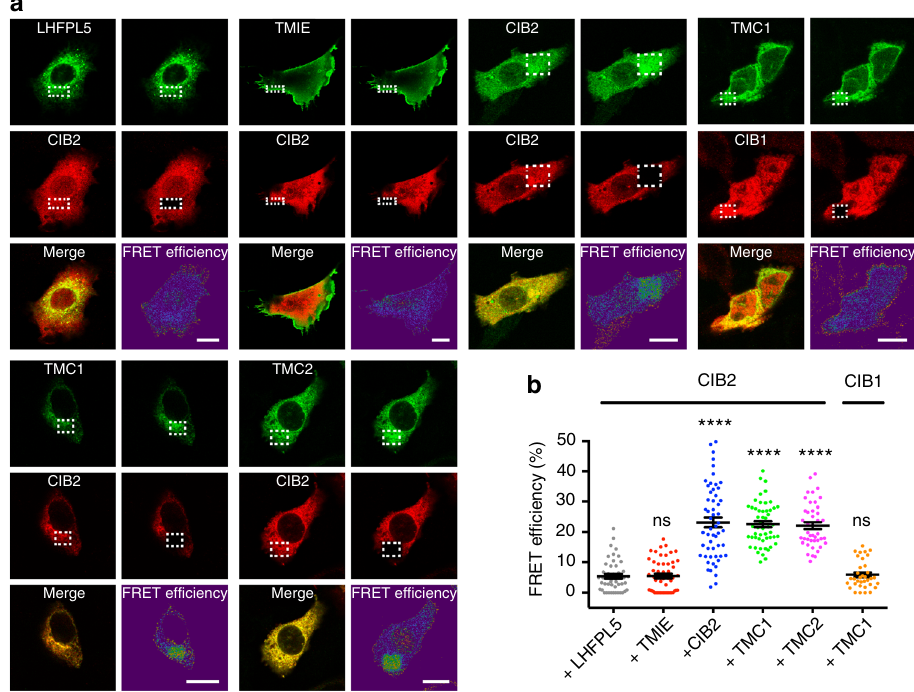
Fig. 7 CIB2 interacts with TMC1 and TMC2. a Fluorescent images of cells co-expressing LHFPL5-GFP, TMIE-GFP, CIB2-GFP (positive control), TMC1-EGFP or TMC2-EGFP (donor) and CIB2-V5 (acceptor) before and after acceptor photobleaching within the indicated region ( white box ). For negative control, we used TMC1-EGFP (donor) and CIB1-V5 (acceptor). FRET ef fi ciency images are calculated as E FRET = 100 × ( I Post − I Pre )/ I Post , where I Pre and I Post are the EGFP pixel intensities before and after acceptor bleaching, respectively. Scale bars: 10 µ m. b Quantitative analysis of FRET ef fi ciency in CHO-K1 cells co-expressing LHFPL5-GFP, TMIE-GFP, CIB2-GFP, TMC1-EGFP or TMC2-EGFP (donor) and CIB2-V5 (acceptor). Quantitative analysis of negative